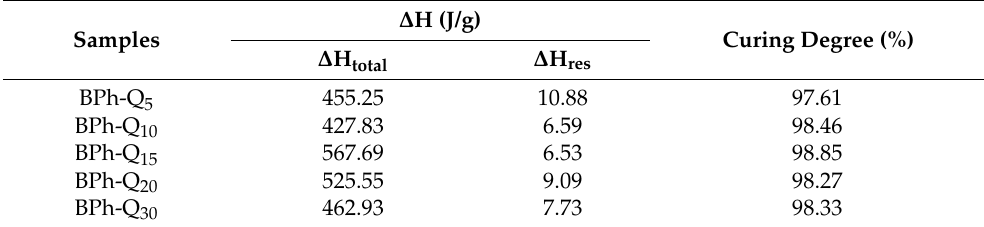
Figure 3. DSC curves of BPh monomers and prepolymers. ( a ) DSC curves of BPh, BPh-B and BPh-Q 10 ; ( b ) DSC curves of BPh-Q 5 , BPh-Q 10 , BPh-Q 15, BPh-Q 20 and BPh-Q 30 , the experimental temperature ranges from 50 to 400 ◦ C, with a heating rate of 10 ◦ C/min (under nitrogen atmosphere) and a purge of 50 mL/min. Table 2. Curing degree of BPh-Q